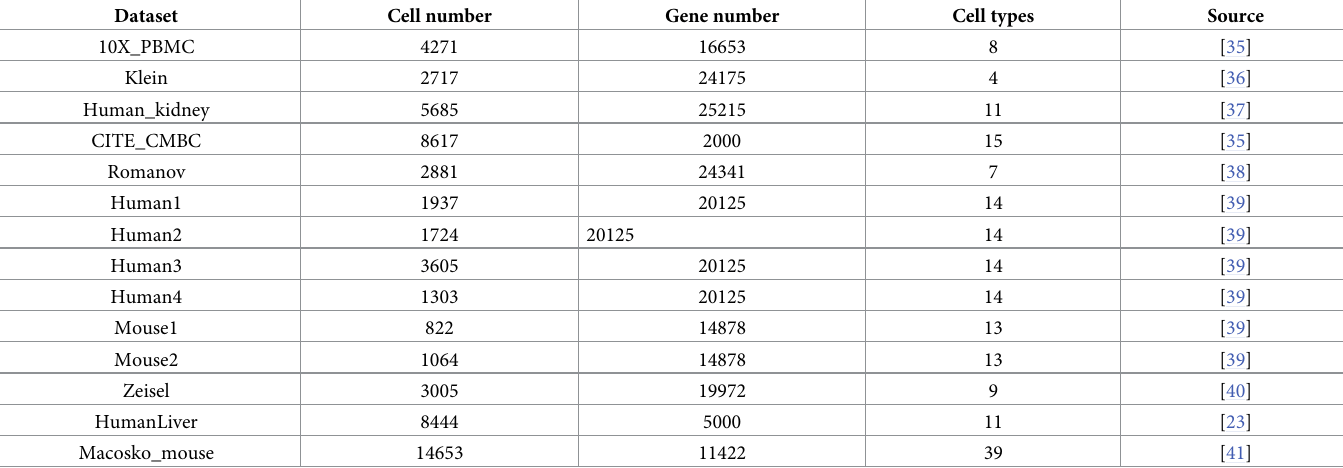
Table 1. The details of scRNA-seq datasets used in paper.